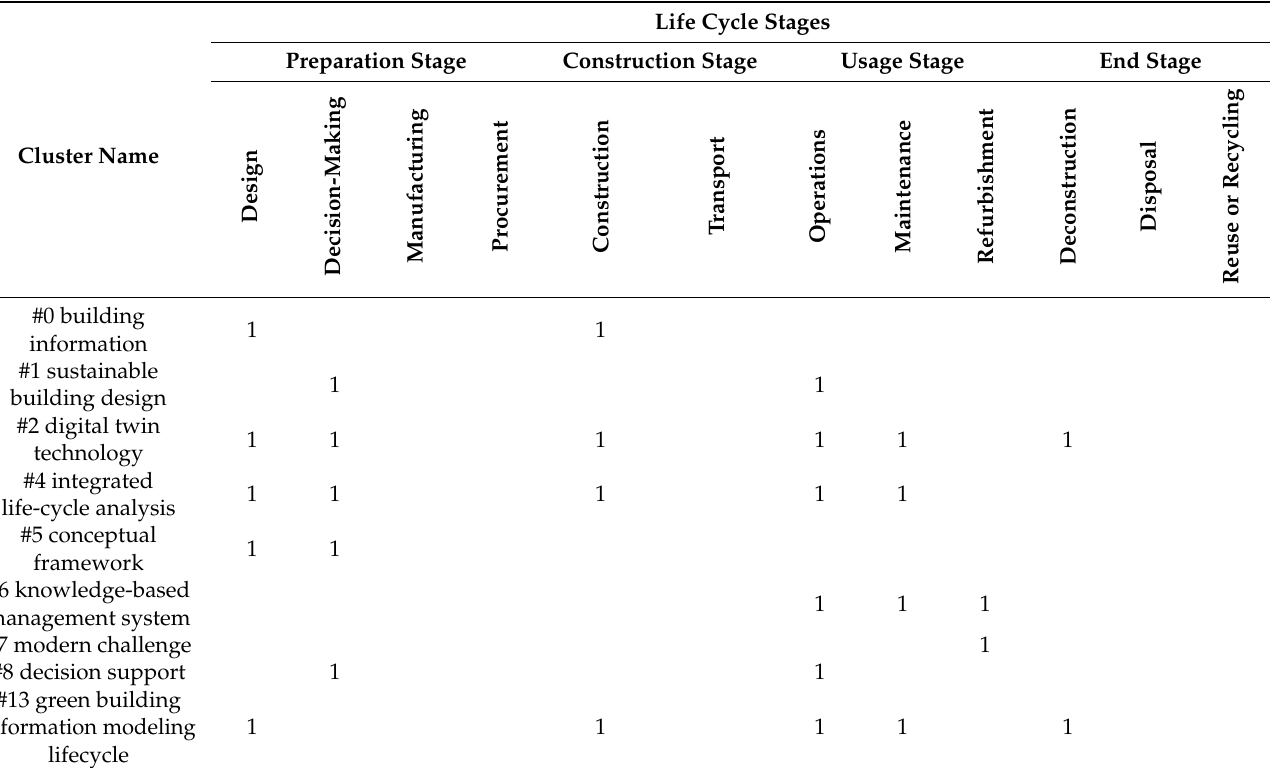
Table 4. Life cycle stages involved in each clustering study (generated by the